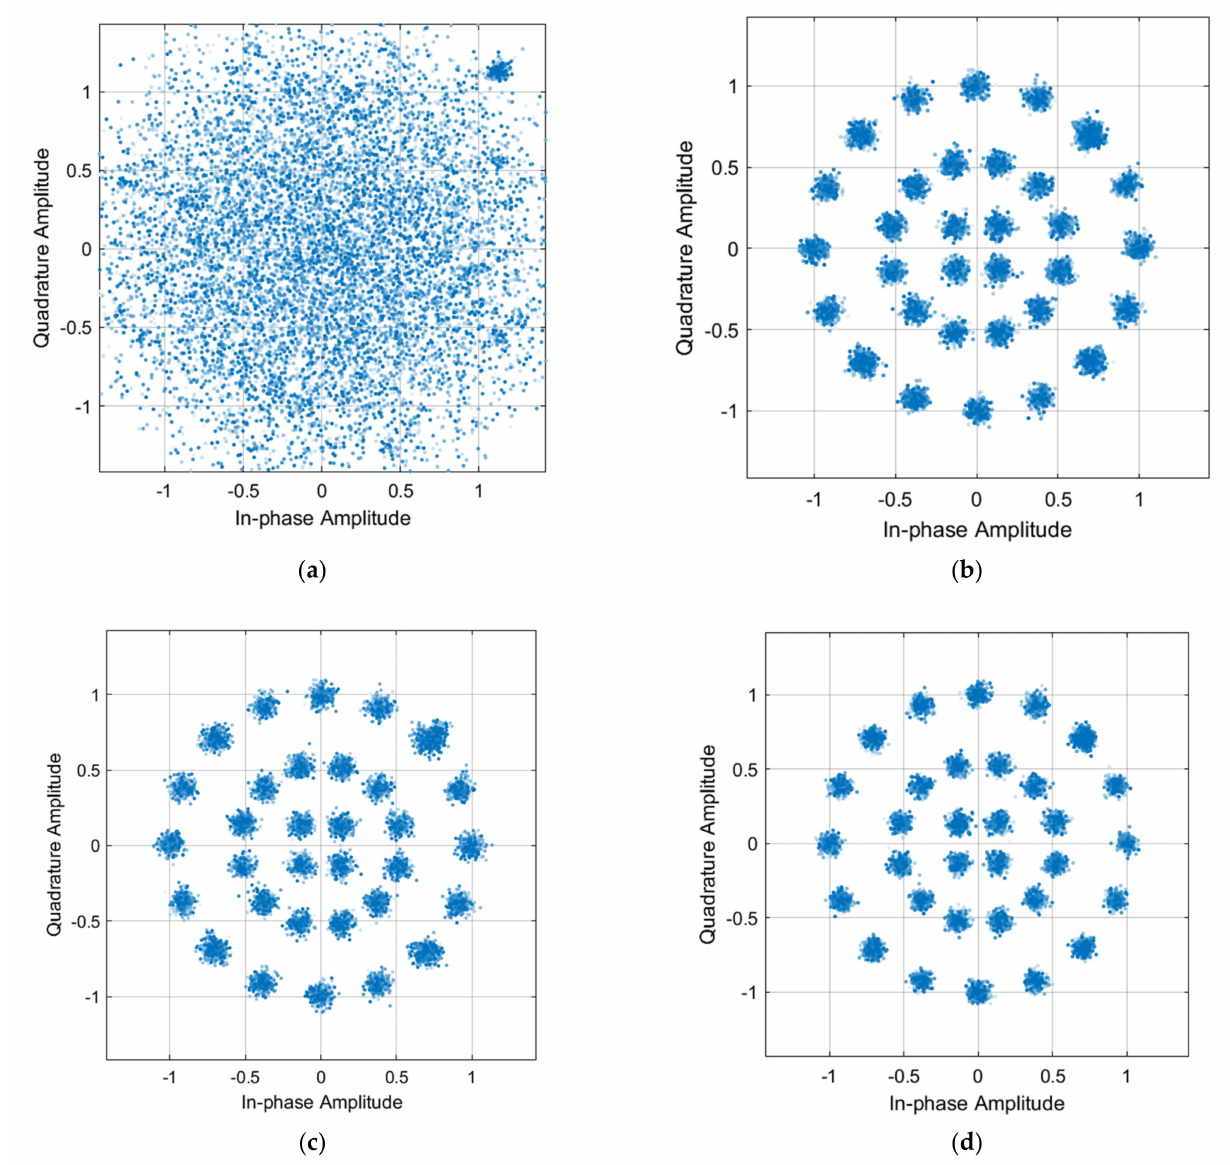
Figure 5. ( a ) Equalizer input signal constellation; ( b ) CMA equalizer output signal constellation; ( c ) MCMA equalizer output signal constellation; ( d ) VM-DDLMS equalizer output signal